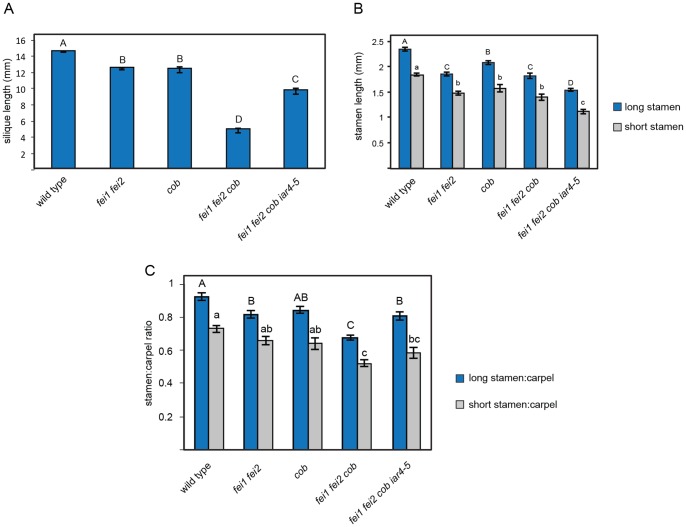
Effect of iar4-5 on floral phenotypes of fei1 fei2.(A) Silique length from indicated genotypes. Plants were grown on soil under 16h light regime for four weeks at 22°C. The first five fully developed siliques from the primary inflorescences were used for the analysis. Values are the mean ± SE (n = 25). (B) Stamen length and (C) Carpel:stamen ratio of indicated genotypes. Stamens and carpels were removed from individual flowers and measured. Values are the mean ± SE (n>11). Different letters indicate significant differences between groups. Data were analyzed with one-way ANOVA and Tukey's post-hoc comparisons; P<0.05.